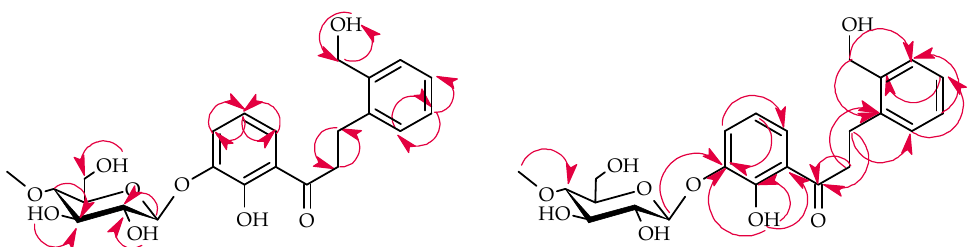
OH OOHO OOHO Scheme 4. Key COSY ( on the left ) and HMBC ( on the right ) correlations for the structure elucidation Scheme 4. Key COSY (on the left) and HMBC (on the right) correlations for the structure of product ( 3b ). elucidation of product ( 3b ). (Supplementary Materials: Figure S54) (Scheme 4). OH OH OH OH